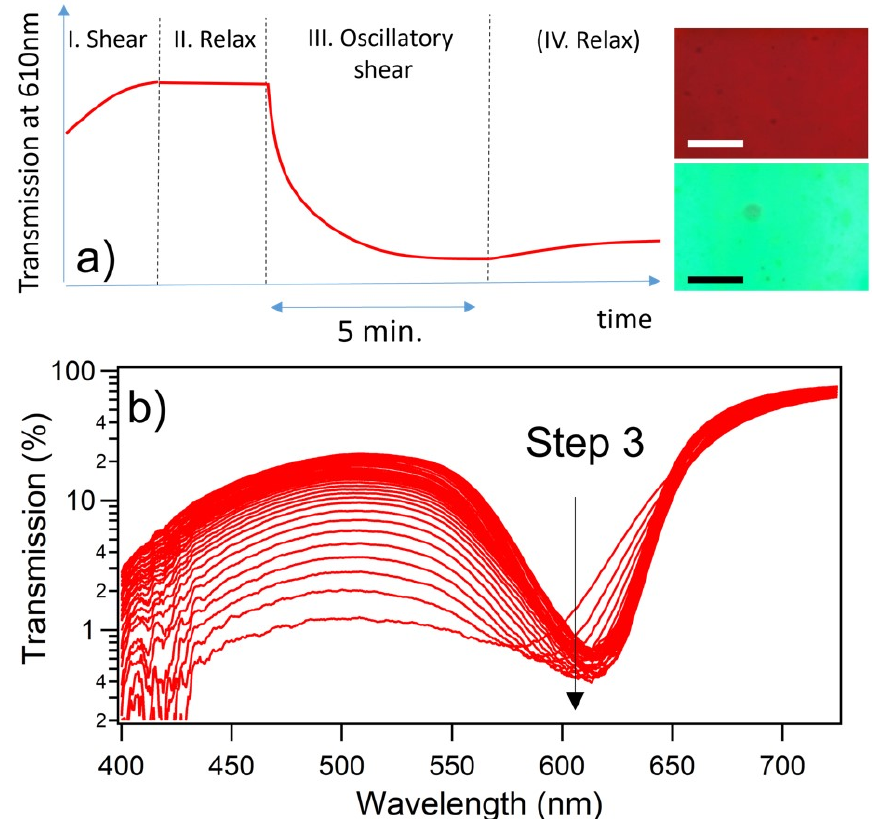
Figure 2. ( a ) Schematic illustration of the evolution of the stopband transmittance during the three- step characterization sequence, with a final relaxation step at the end of oscillatory shear. The photographic images in the inset compare the appearance of transmitted white light through the shear cell before (top) and after (bottom) the main oscillatory-shear cycle; uniform ordering, and a characteristically intense green structural color, are in evidence in the latter case. Both images were captured using an Olympus BX43 microscope, magnification × 5, and image scale bars ≈ 100 µ m. In ( b ), transmission spectra are shown evolving with time during the oscillatory shear-ordering phase (step 3 in cycle). Successive spectra are 0.5 s apart in time, allowing a data slice at the photonic stopband minimum at λ = 610 nm, as illustrated by the